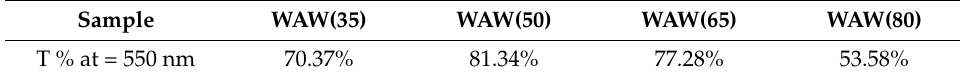
Figure 13. UV-Vis spectrum of WAW films at different top-WO 3 thicknesses. Table 4. Light transmittance of WAW films at different top-WO 3 thicknesses.